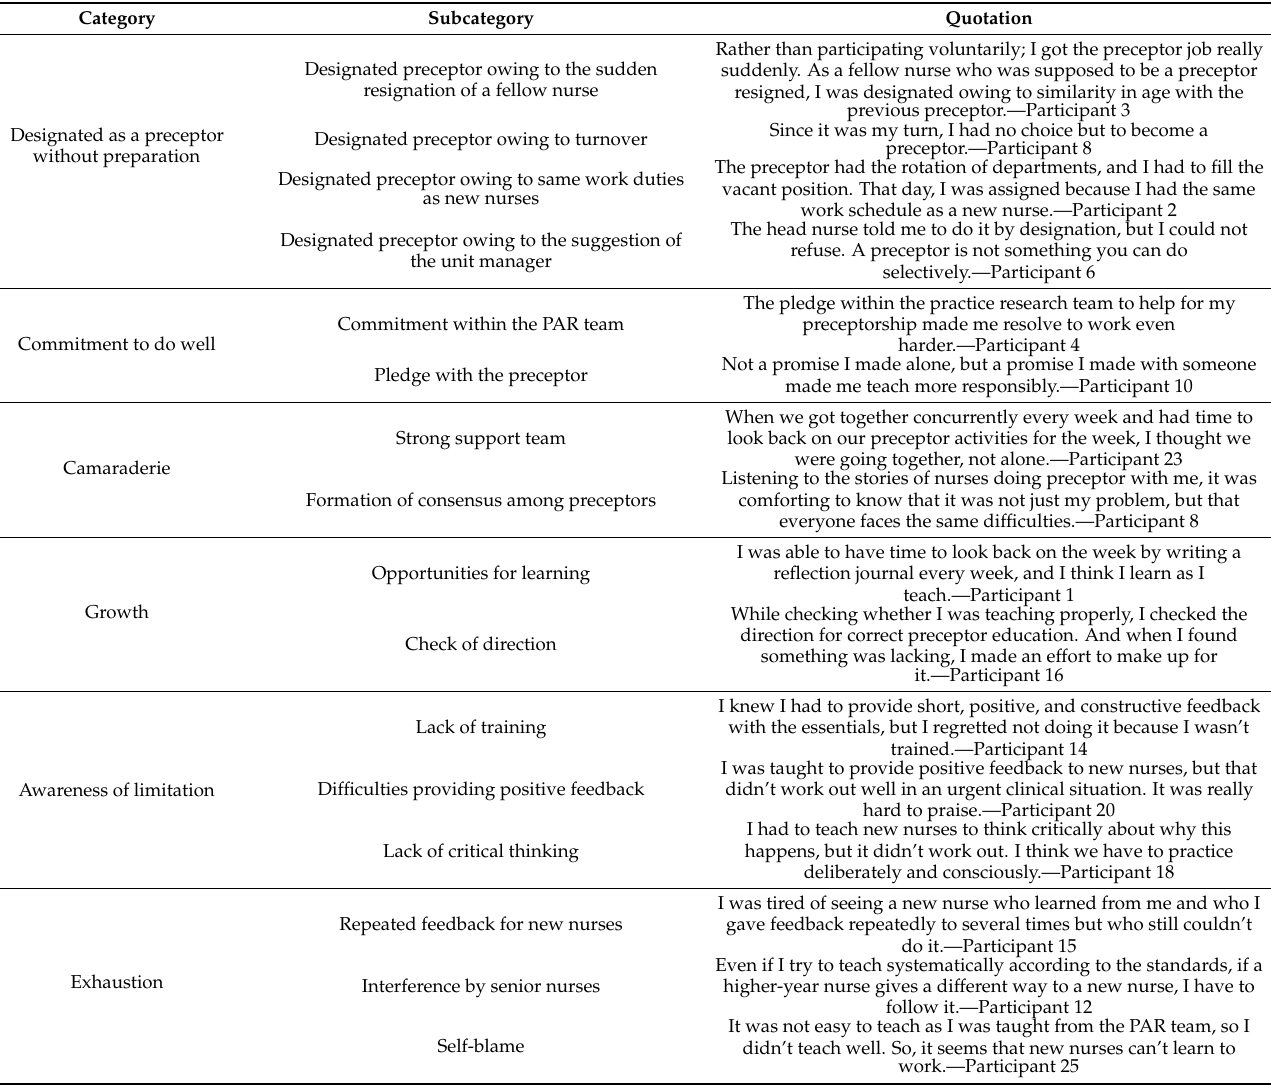
Table 3. Content analysis of participation experiences from reflective